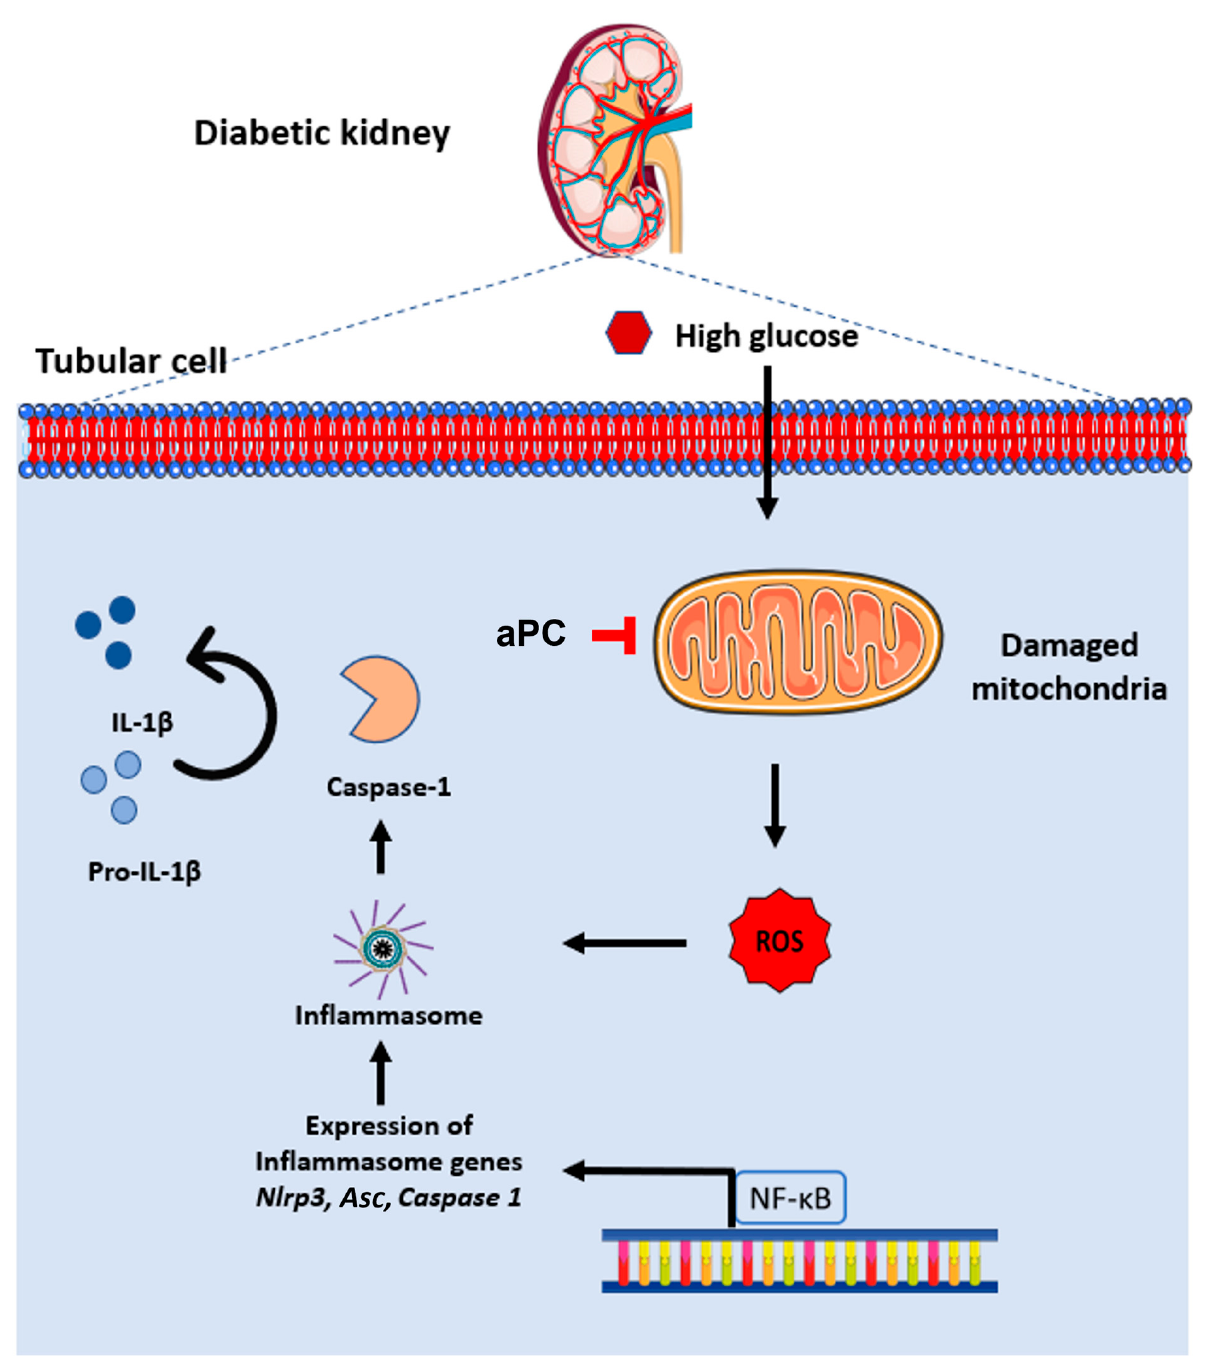
Figure 5. Visual abstract: aPC protects the kidney from high glucose-induced ROS-dependent inflammasome activation. aPC = activated protein; ASC = adaptor molecule apoptosis-associated speck-like protein containing a CARD; Casp1 = Caspase- 1; IL-1 β = Interleukin-1 β ; NF- κ B = Nuclear factor kappa-light-chain-enhancer of activated B cells; NLRP3 = NLR family pyrin domain containing 3; ROS = reactive oxygen species.